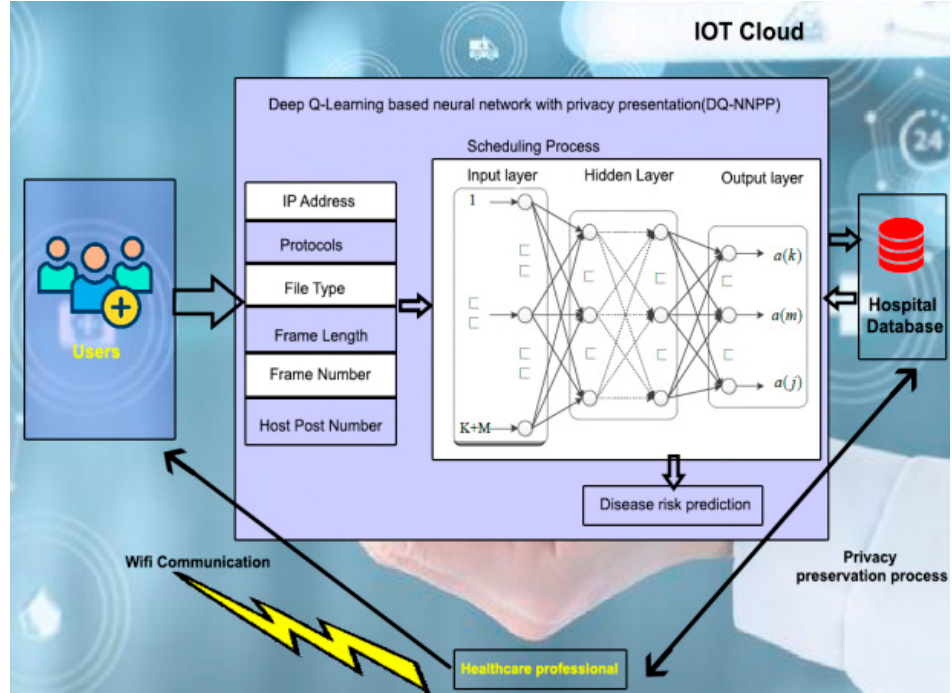
Figure 1. System architecture of privacy preservation method in IoT healthcare infrastructure.